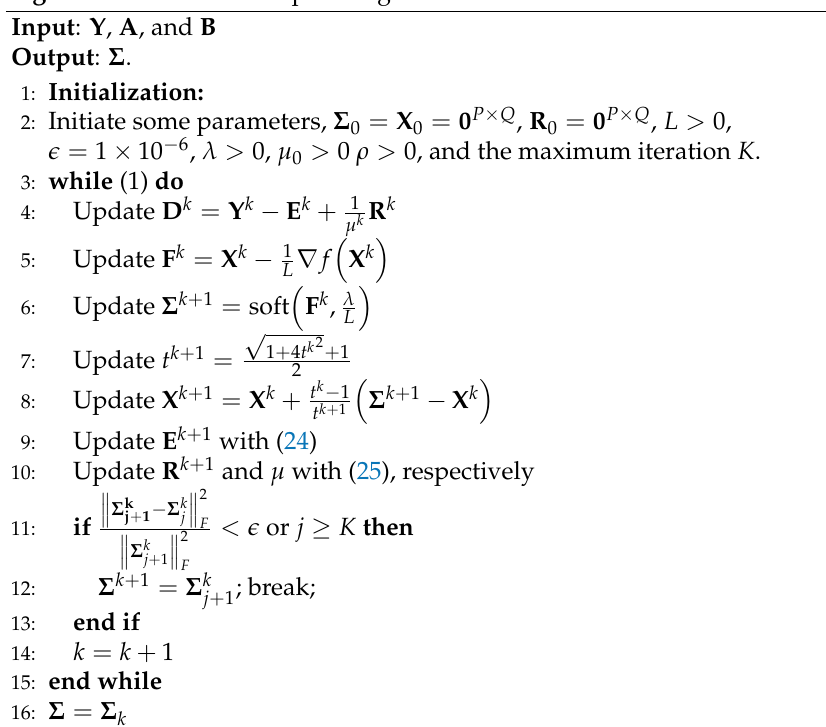
Algorithm 4 The inexact sparse